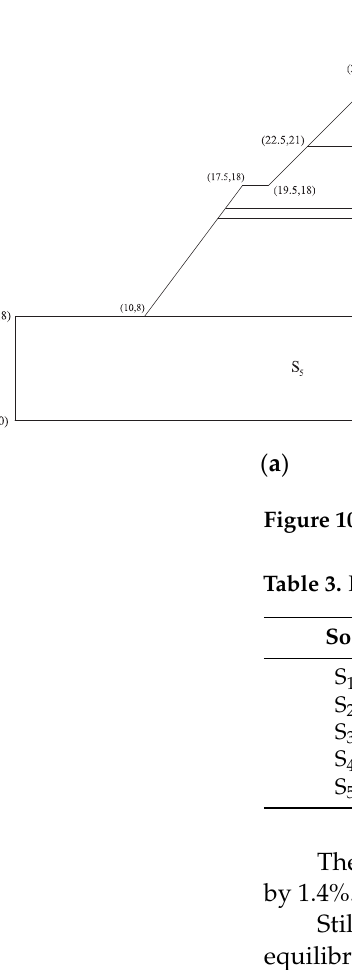
( b ) Figure 9. Distributions of the equivalent plastic strain. ( a ) intact M–C; ( b ) cut-off M–C.